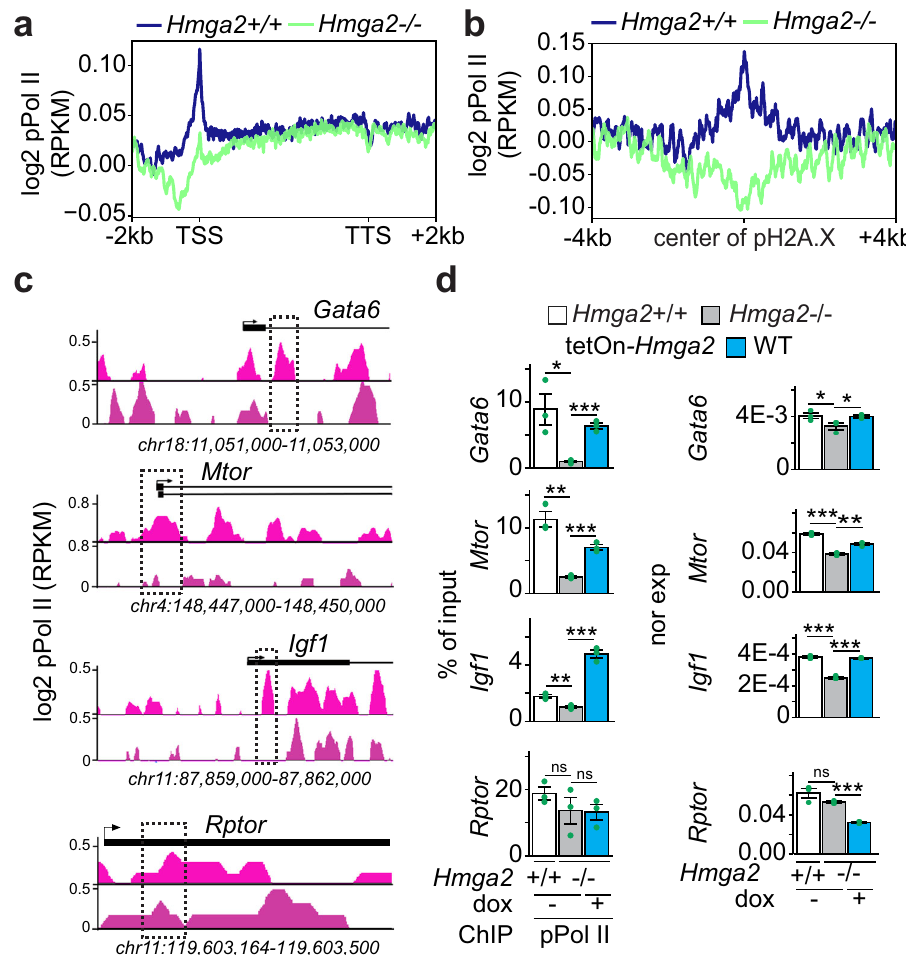
Fig. 2 Position of transcription initiating S5 phosphorylated RNA polymerase II at the TSS is Hmga2 -dependent. a , b Aggregate plots for phosphorylated serine 5 RNA polymerase II (pPol II) enrichment within the gene body ±2 kb of UCSC Known Genes ( a ) and in a ± 4 kb region respective to pH2A.X peaks ( b ) in Hmga2 + / + and Hmga2 − / − MEF. ChIP-seq reads were normalized using reads per kilobase per million (RPKM) measure and are represented as log2 enrichment over their corresponding inputs. TSS, transcription start site; TTS, transcription termination site. c Visualization of selected HMGA2 target genes using UCSC Genome Browser showing pPol II enrichment in Hmga2 + / + and − / − MEF. ChIP-seq reads were normalized using RPKM measure and are represented as log2 enrichment over their corresponding inputs. Images represent the indicated gene loci with their genomic coordinates. Arrows, direction of the genes; black boxes, exons; dotted squares, regions selected for single gene analysis. d Analysis of selected HMGA2 target genes. Left, ChIP of Gata6 , Mtor , Igf1 and Rptor after pPol II immunoprecipitation in Hmga2 + / + and Hmga2 − / − MEF. Right, qRT-PCR-based, Tuba1a -normalized expression analysis under the same conditions. Bar plots presenting data as means; error bars, s.e.m ( n = 3 biologically independent experiments); asterisks, P -values after two-tailed t -test, *** P ≤ 0.001; ** P ≤ 0.01; * P ≤ 0.05. See also Supplementary Figs. 1 – 2 . Source data are provided as a Source Data fi les 01 and